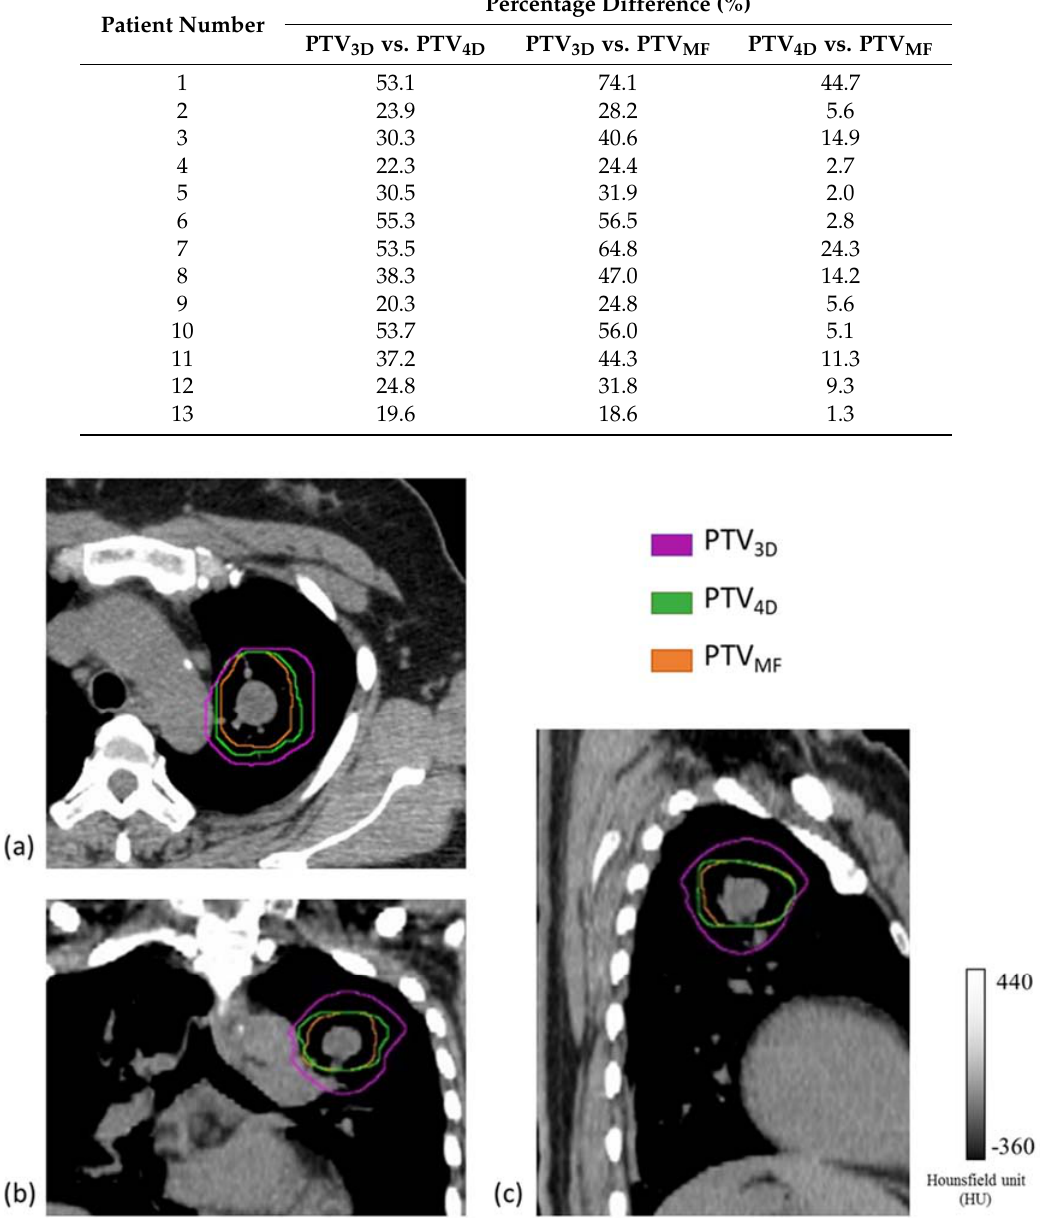
Table 5. Percentage differences in planning target volumes (PTVs) between treatment plans.